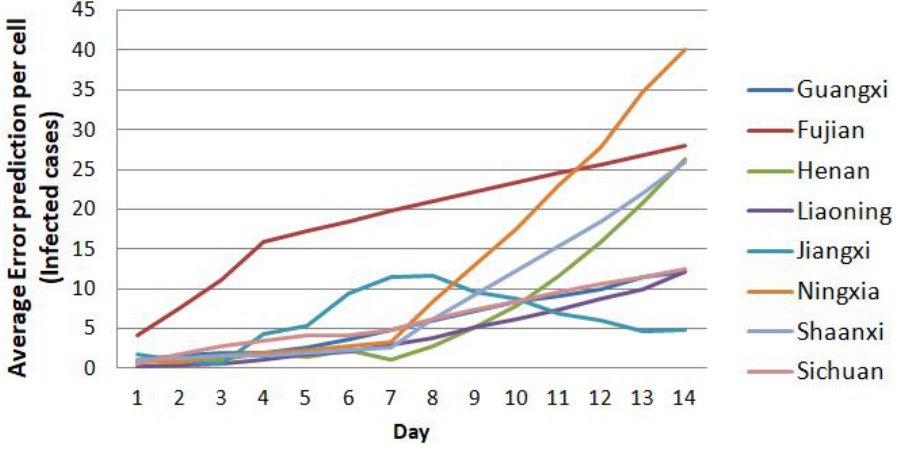
Figure 16. The trend of prediction error below 40 cases per cell until the 14th prediction.